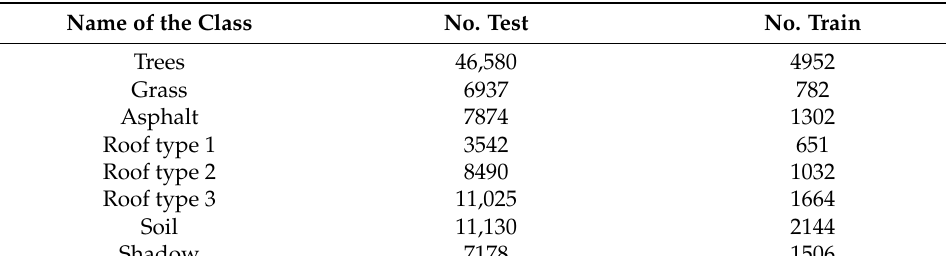
Table 2. The number of test and train pixels of World-View 2 image.